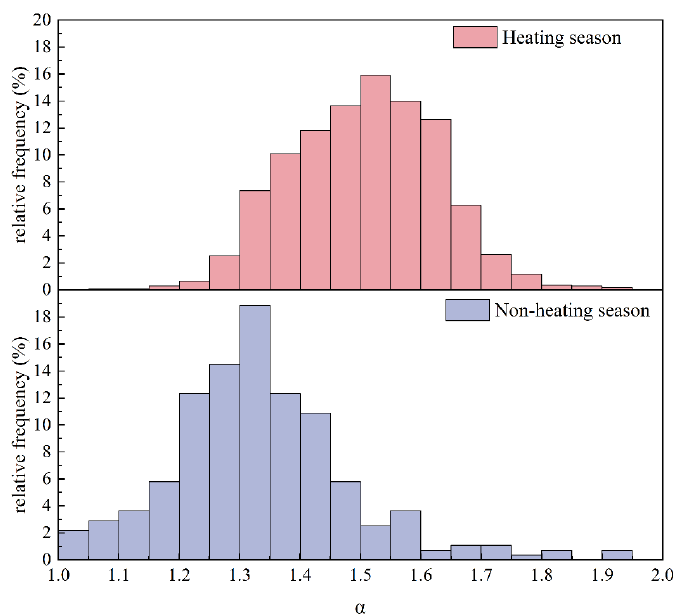
Figure 5. Distribution of α -values frequency in the heating and non-heating seasons, respectively.